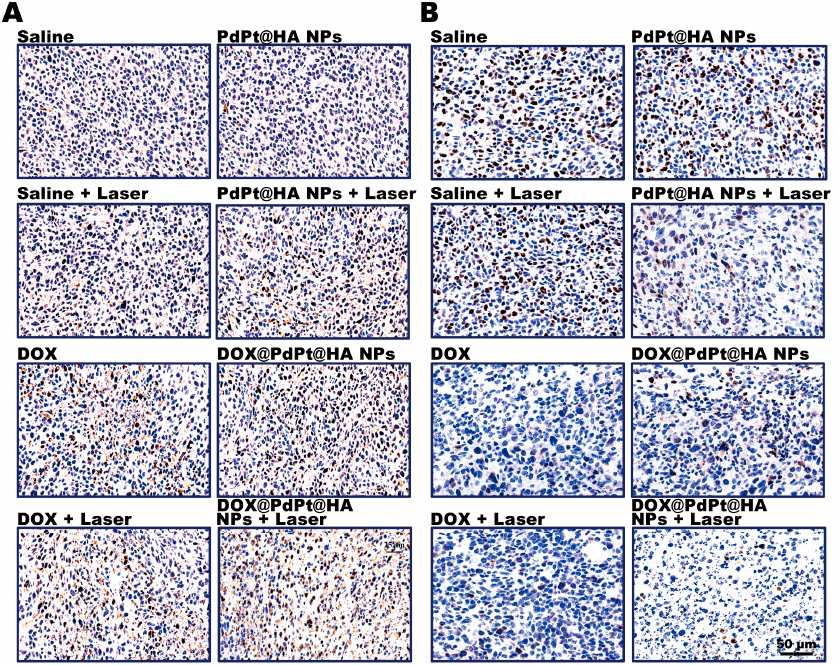
Figure 6. Representative images of caspase-3 ( A ) and Ki-67 ( B ) immunohistochemical staining in tumors from animals with different treatments.